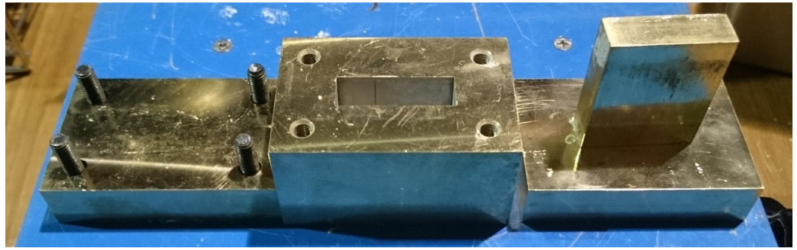
Figure 1. Metal mold for sample preparation.